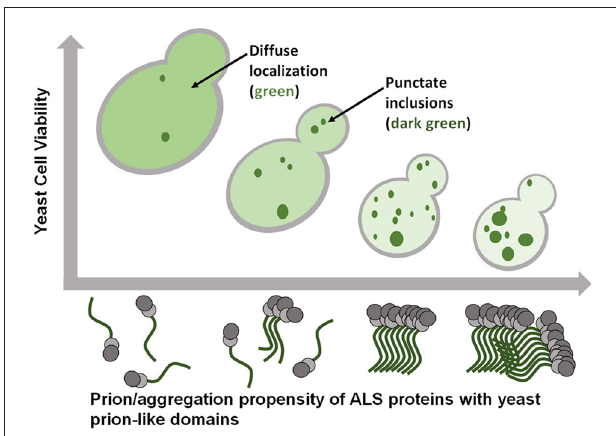
FIGURE 2 | ALS-linked proteins with prion-like domains exhibit gain-of-function toxicity that is tightly associated with the extent of their aggregation. Smaller, more soluble, oligomeric aggregates may be the most toxic